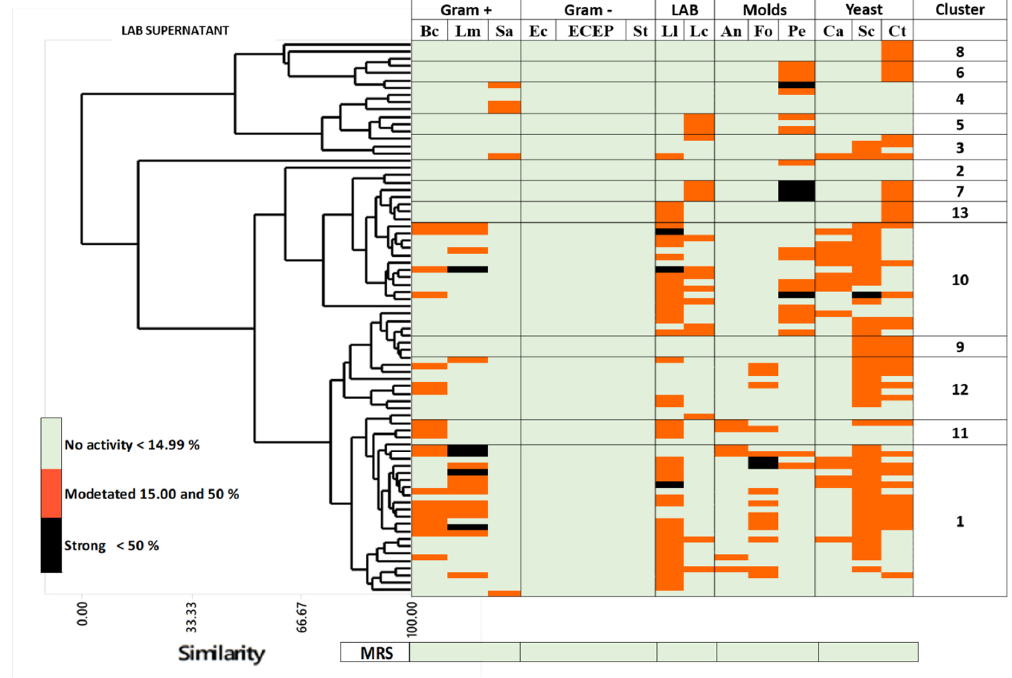
Figure 1. Dendrogram based on the Antimicrobial activity percentages of Lacti Acid Bacteria cell-free supernatants (LAB-CFS) and sterile De Man, Rogosa, and Sharpe (MRS) broth against